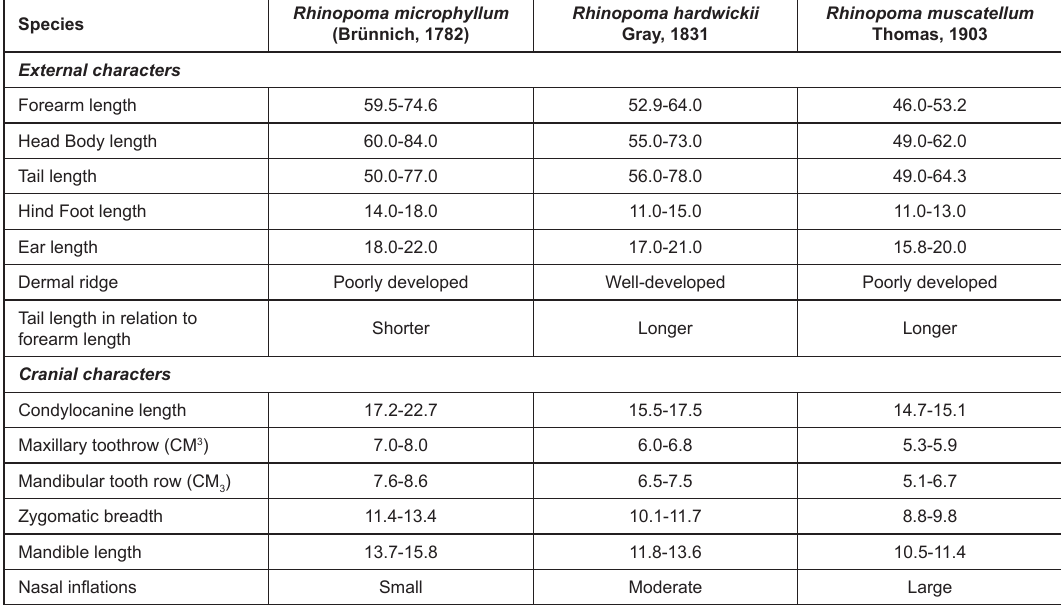
Table 4.1. Diagnostic morphological characters of the three species of the genus Rhinopoma E. geoffroy, 1818 present in South asia